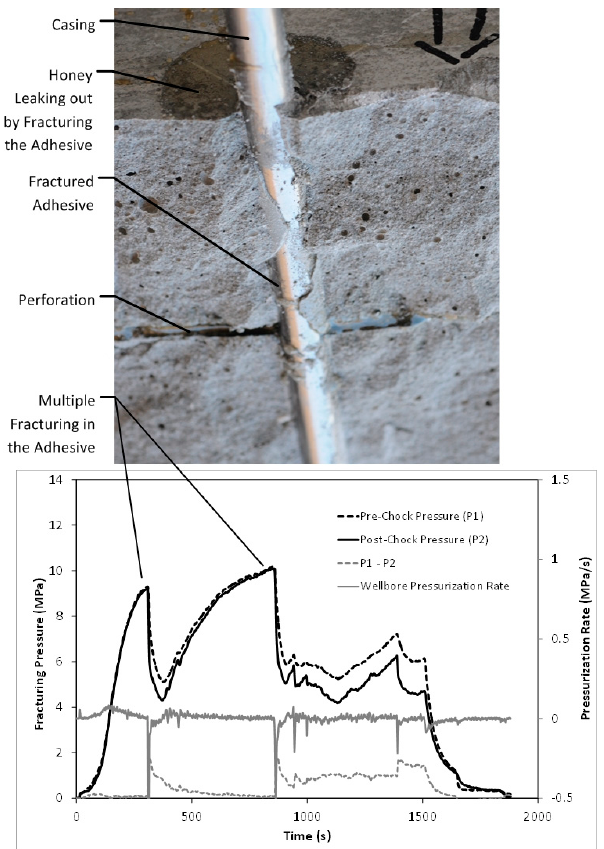
Figure 7. A view of the broken sample H-1 after the test, where fracturing fluid has propagated a fracture in the adhesive ( top ), and the corresponding fracturing pressure graph which shows a typical multi-fracturing mechanism ( bottom ).